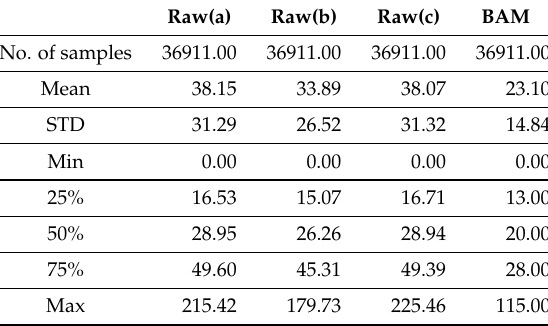
Table A2. Descriptive statistic summary of low-cost sensor and governmental BAM (before